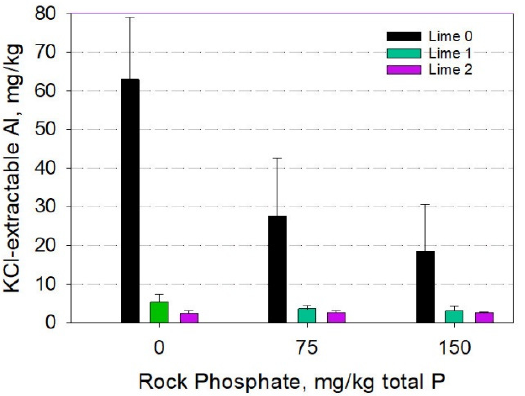
Table 1. Total nutrient contents of cowpea green manure, rock phosphate, and coral lime used in the experiment. Figure 2. Soil Al as affected by lime and rock phosphate. Error bars on top of larger bars are the standard deviation of the measured samples. Table 3. 3-way factorial ANOVA and associated P-values (probability of significance) for selected measured parameters (dependent variables) of soil and plant as impacted by lime, rock phosphate (RP) and green manure (GM) amendments on an Oxisol of Hawaii.